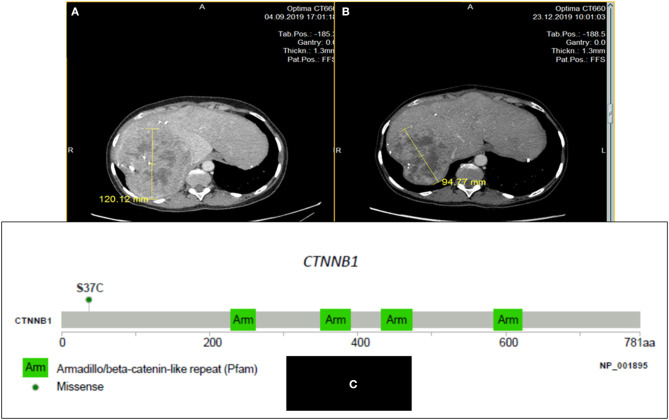
CT scan images of the large liver metastasis of a pancreatoblastoma (patient # 1) in a 33 year-old woman: before (A) and after six cycles (B) of FOLFIRINOX regimen: minor response; (C): Lolliplot of CTNNB1 gene showing the S37C mutation in exon 3.